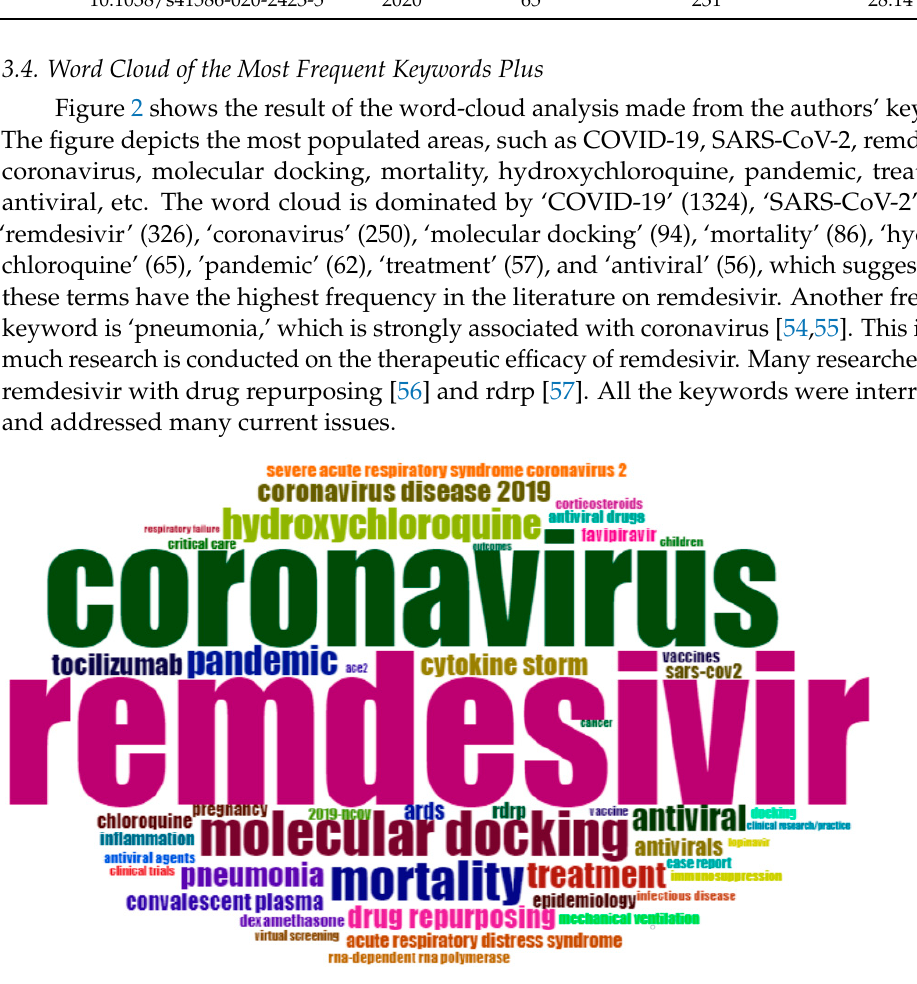
Figure 2. Word cloud of author keywords. The word cloud describes the frequency of author keywords in remdesivir research ( Source: Author